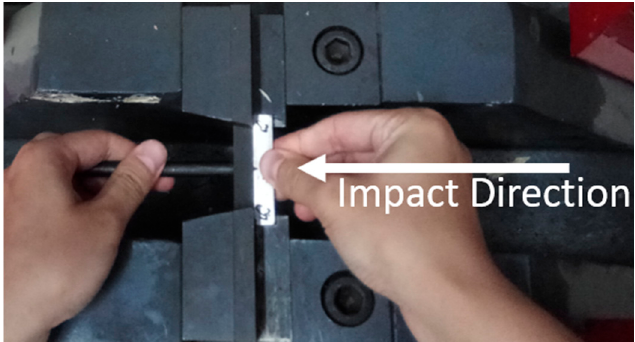
Figure 3. Placement of sample and impact direction.